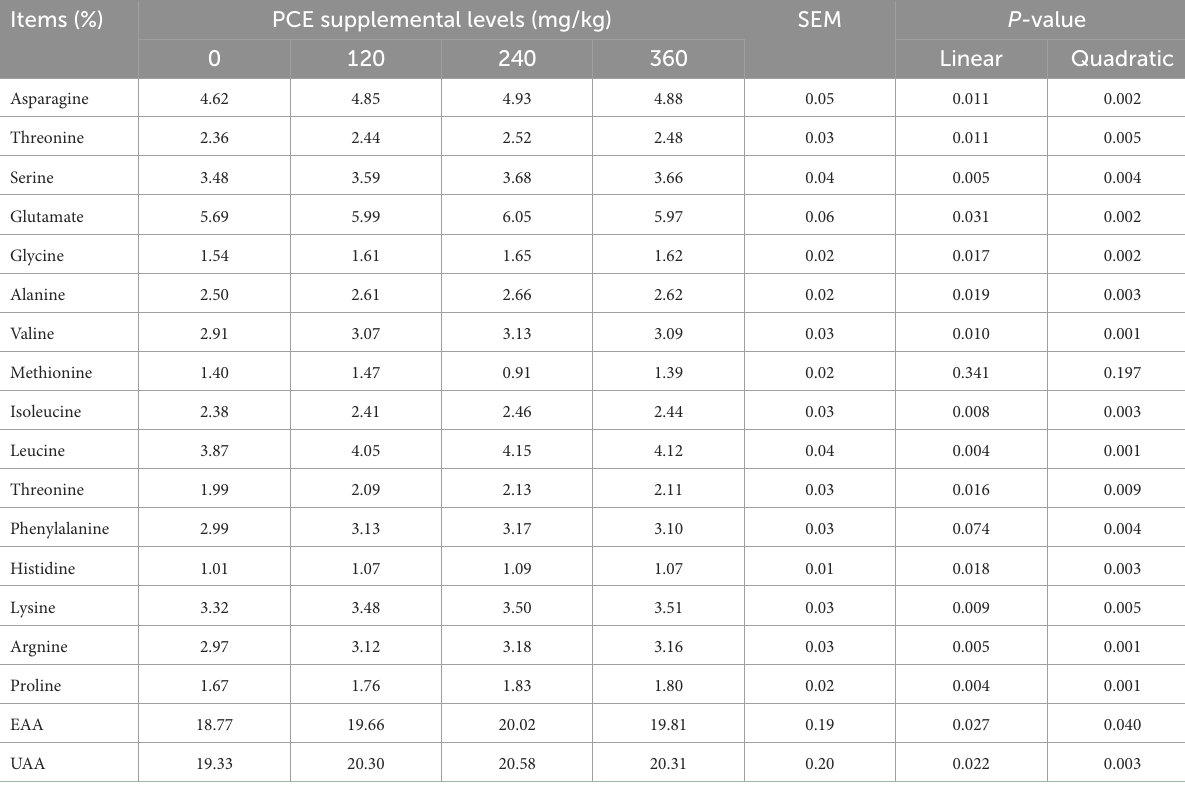
TABLE 5 Effect of purple corn extract on egg amino acid profiles of 99-week-old laying hens. Items